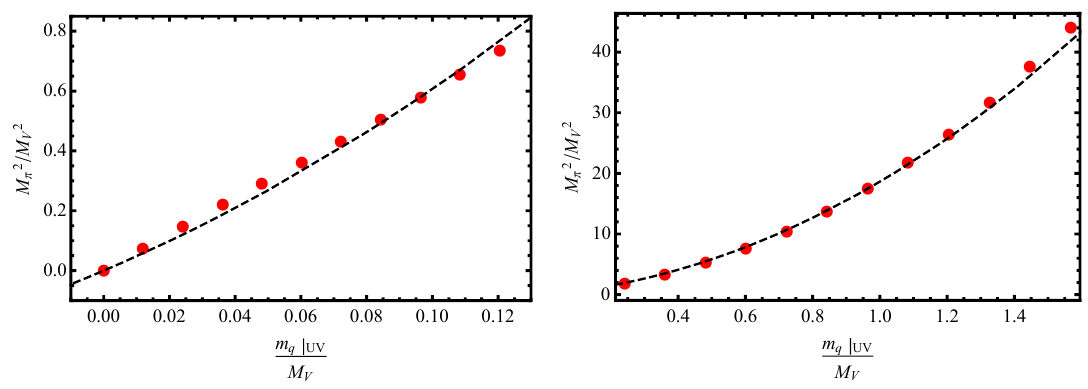
Figure 9. We plot the pNGB mass against the UV quark mass in the small and intermediate quark mass regions for the SU(2) gauge theory (in units of the vector meson mass at m q | UV = 0 ). The red points are the numerical results. The dashed black lines are obtained as a simple analytic fit: M 2 = 4 . 67 m q | UV + 13 . 97 m 2 | UV . π q